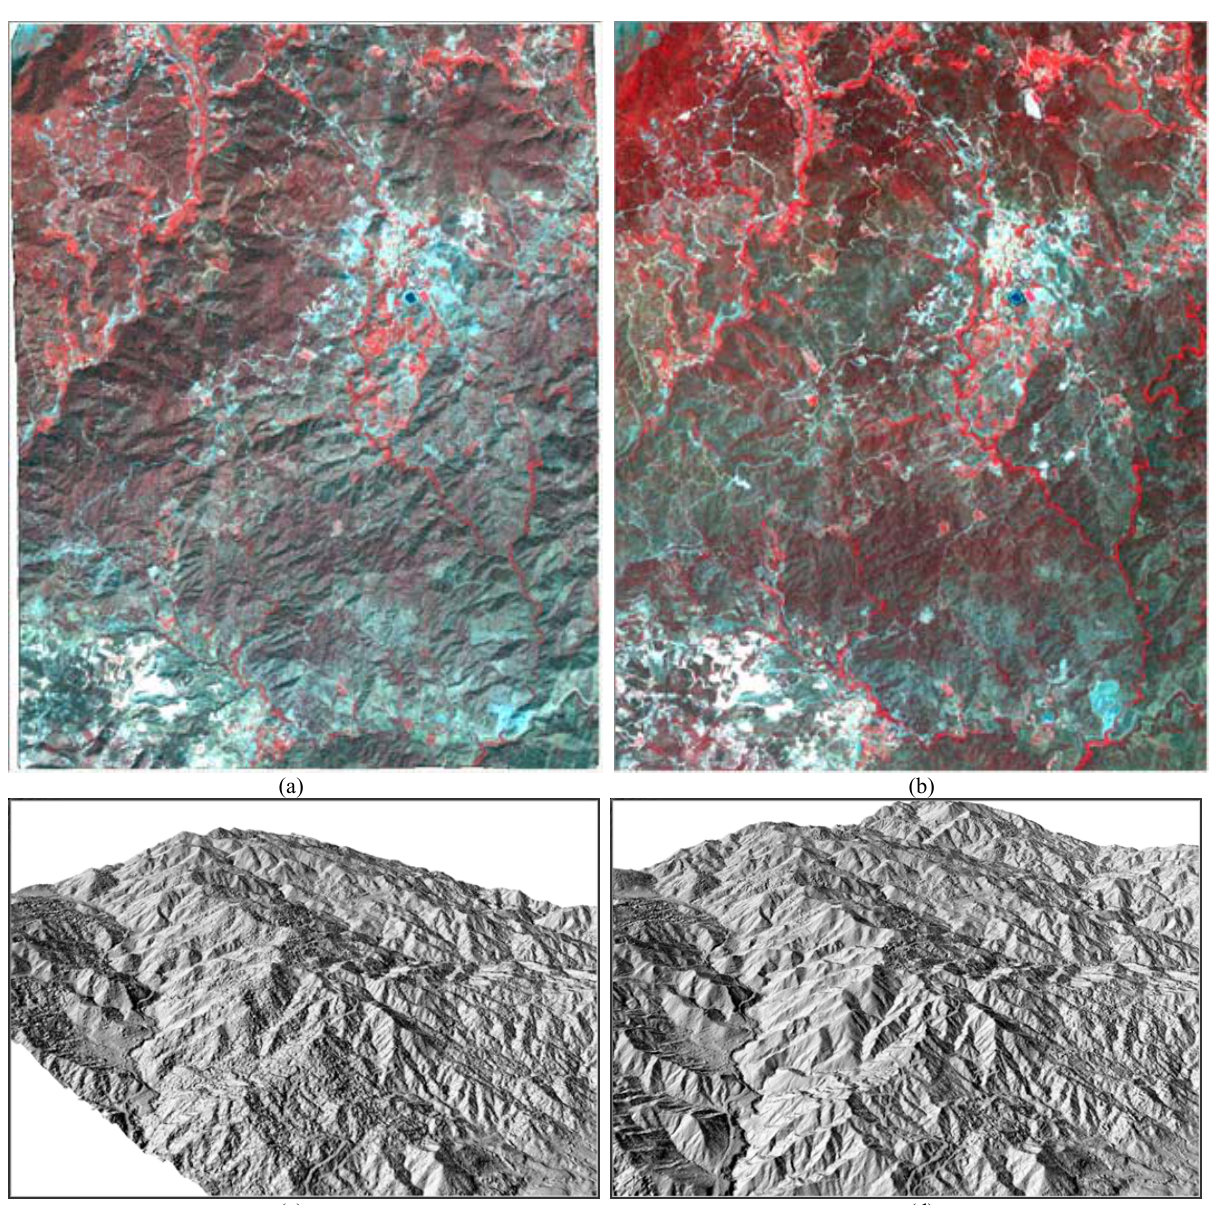
Figure 9. (a) Ikonos image © of October 2001, (b) Pléiades image © of July 2014, (c) Ikonos DSM, (d) Pléiades DSM. FORSAT Consortium © copyright. All rights